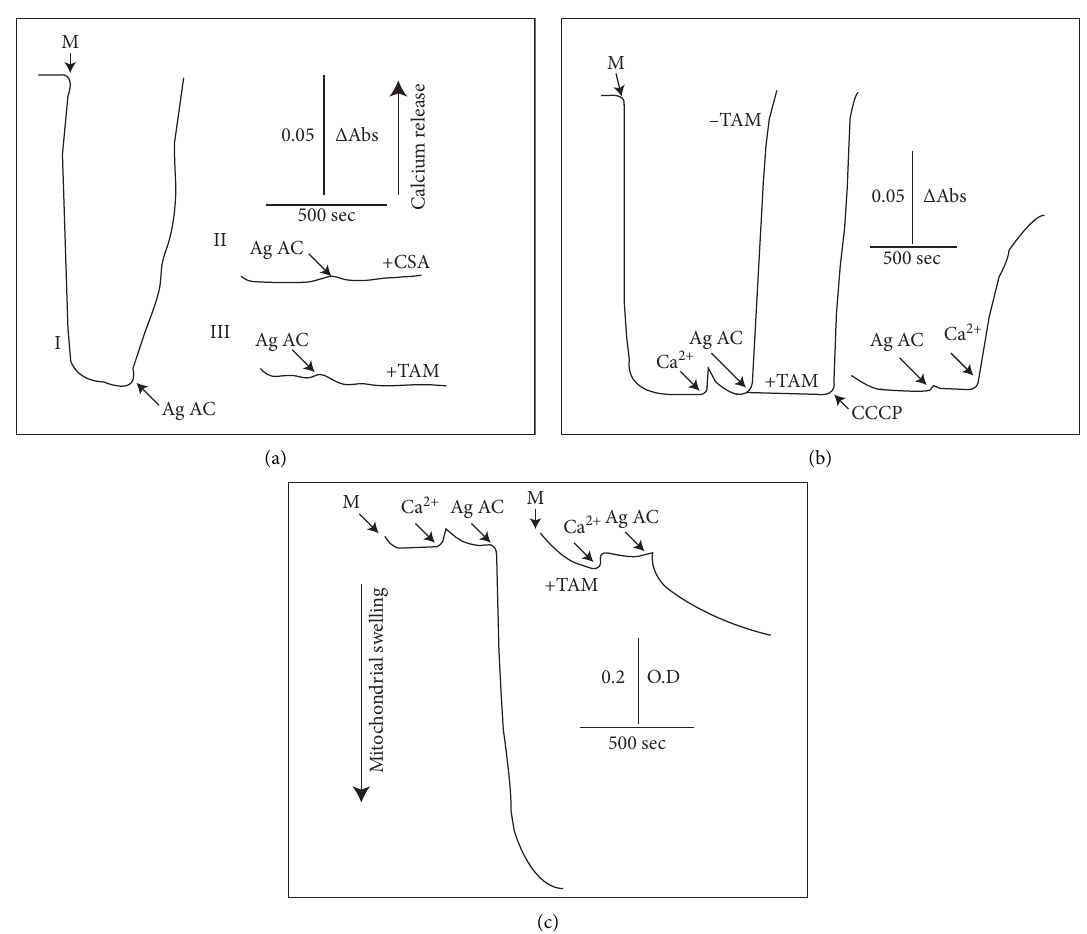
Figure 1: (a) Agaric acid effect on the matrix Ca 2+ content release. Mitochondrial protein (2mg) was added to 3ml of a basic medium as described in Materials and Methods. Where indicated, 3 μ M agaric acid (Ag Ac), 2 µ M cyclosporin A (CSA), and 20 µ M tamoxifen (TAM) were added. Traces are representative of, at least, 4 different experiments. (b) Agaric acid-induced collapse of the transmembrane electric gradient. Mitochondrial protein was incubated in 3ml of a medium. Where indicated, 50 µ M CaCl 2 , 3 µ M agaric acid, 20 µ M tamoxifen, and 1 µ M of the uncoupler CCCP were added. (c) Attenuation by tamoxifen of the agaric acid-induced mitochondrial swelling. Mitochondrial protein was incubated in 3 ml of basic. Where indicated, 50 µ M CaCl 2 , 3 µ M agaric acid, and 20 µ M tamoxifen were added. Temperature: 25 ° C. Traces are representative of, at least, 4 different